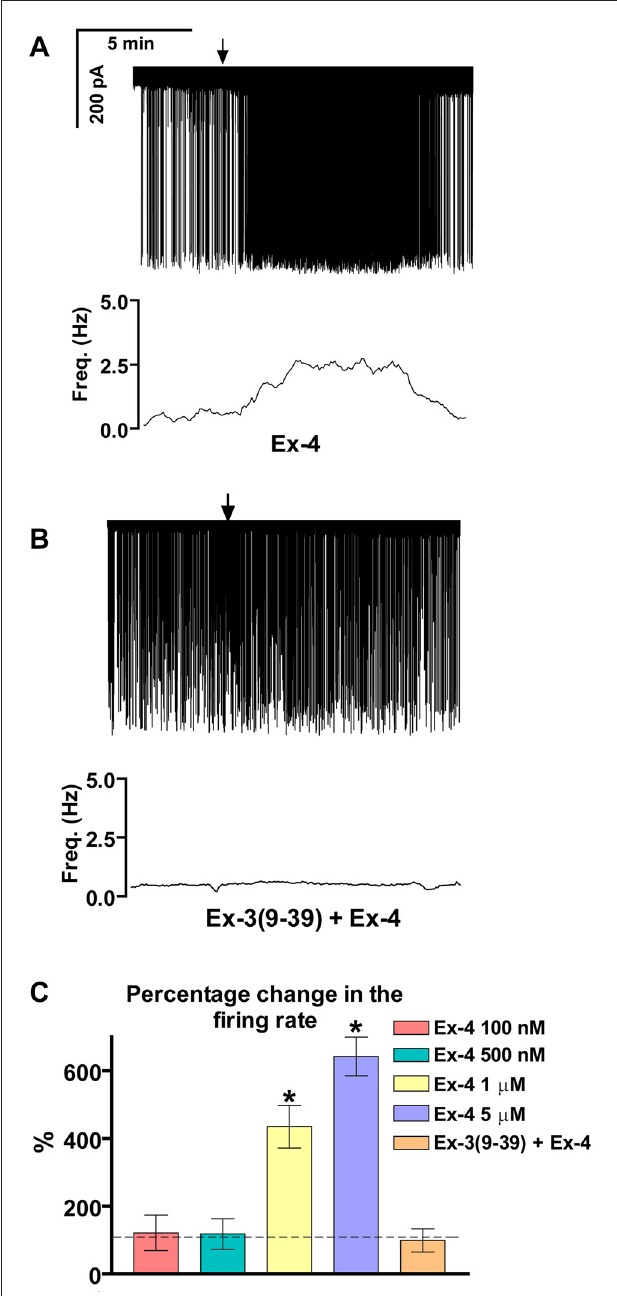
FIGURE 1 | Effect of glucagon-like peptide-1 (GLP-1) agonist Exendin-4 on the firing of gonadotropin-releasing hormone (GnRH) neurons in brain slices of male mice. (A) 1 µ M Exendin-4 increases the firing rate in GnRH neurons in 5 min. The frequency distribution graph under the recording also shows this profound change. (B) Pretreatment of the brain slice with the GLP-1 receptor (GLP-1R) antagonist Exendin-3(9–39) (1 µ M) inhibits the effect of Exendin-4 on firing. The frequency distribution graph under the recording confirms this observation. (C) Bar graph shows the significant change in the firing rate at 1 and 5 µ M, but not at 100 and 500 nM. The graph also demonstrates elimination of the effect upon pretreatment the brain slice with the GLP-1R antagonist. Arrows show application of Exendin-4. ∗ p < 0.05.